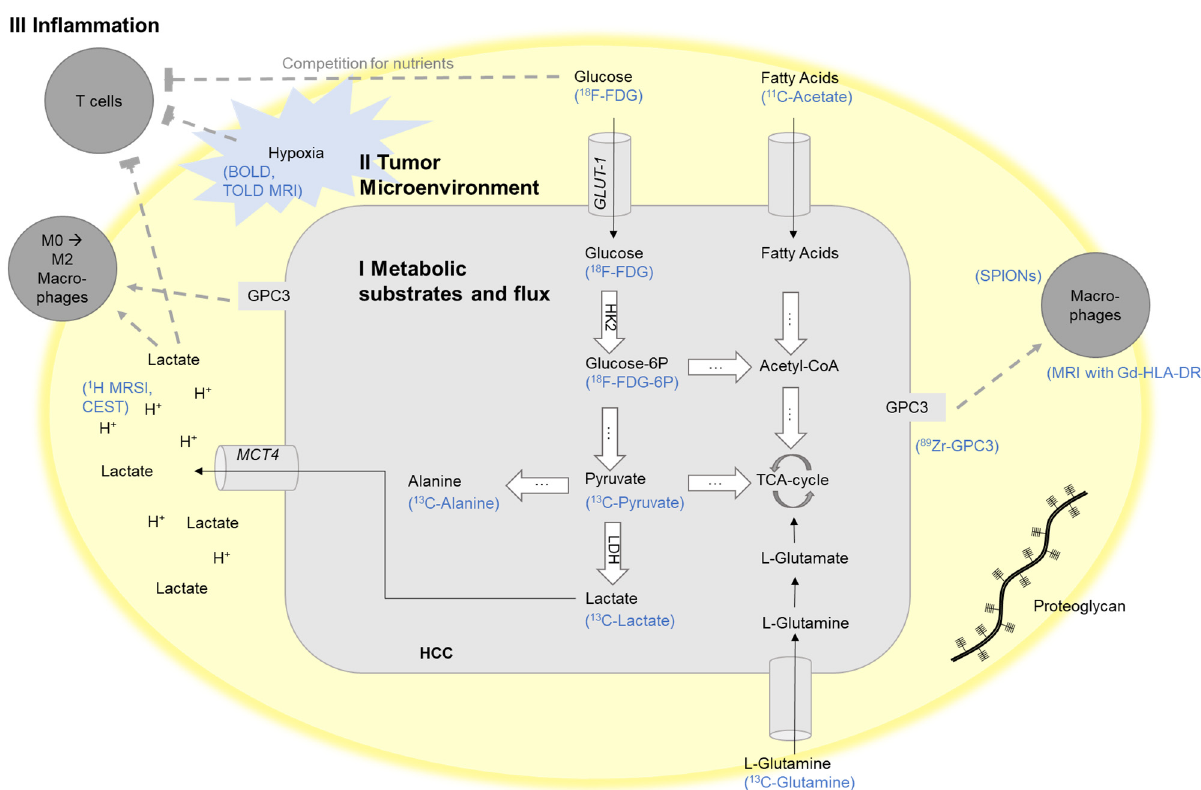
Figure 1. Schematic illustration of exemplary targets for the imaging of the crosstalk between the tumor cells and their tumor microenvironment mediated through tumor metabolism. BOLD, blood-oxygen-level-dependent MRI; CEST, chemical exchange saturation transfer; FDG, fluorodeoxyglucose; Gd-HLA-DR, gadolinium-conjugated antibodies against HLA-DR; HK-2, hexokinase-2; GAG, glycosaminoglycan; Glucose-6P, Glucose-6-phosphate; GLUT1, glucose transporter 1; GPC3, glypican-3; HCC, hepatocellular carcinoma; LDH, lactate dehydrogenase; MCT4, monocarboxylate transporter 4; MRI, magnetic resonance imaging; MRSI, magnetic resonance spectroscopic imaging; SPIONs, superparamagnetic iron oxide nanoparticles; TCA-cycle, tricarboxylic acid cycle; TOLD, tissue oxygenation level-dependent MRI. Adapted and modified from [37].